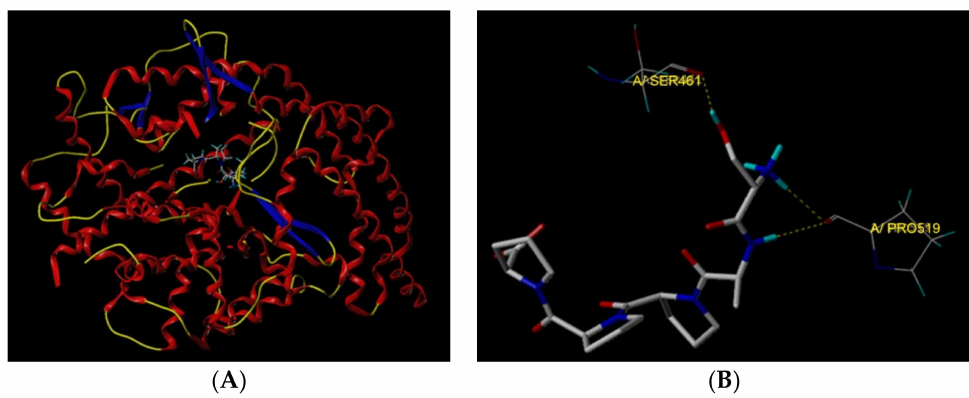
Figure 5. General overview ( A ) and local overview of the best-ranked docking pose ( B ) of SAPPP binding with ACE (PDB: